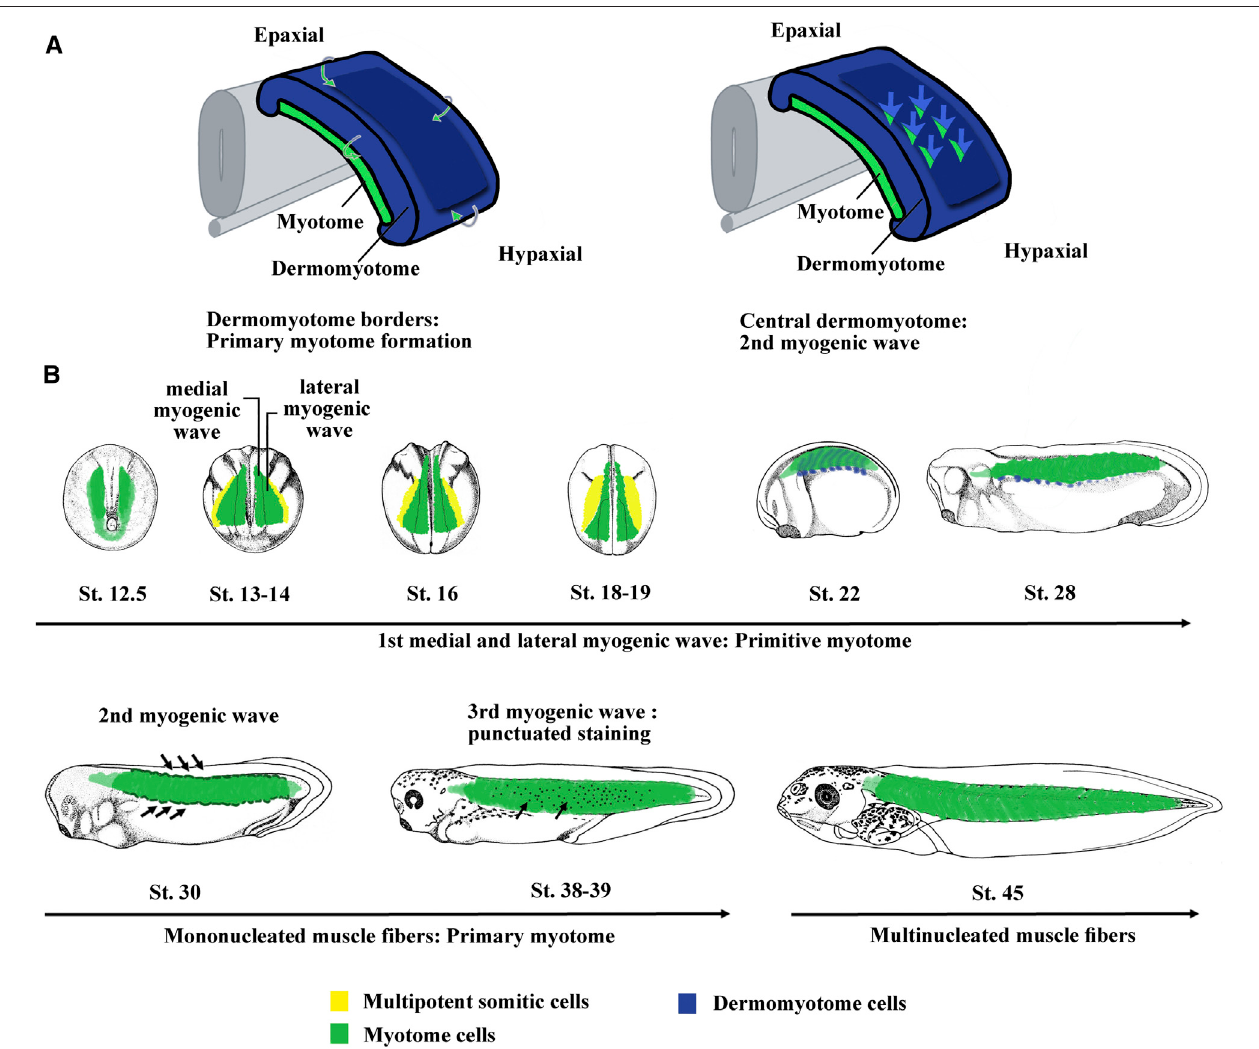
FIGURE 2 | The myogenic waves and the myotome formation in amniotes and Xenopus . (A) The myotome is essentially derived from the dermomyotome in amniotes.Theprimarymyotomeismadeofmononucleatedcellsarisingfromthefourbordersofthedermomyotome.Nextcellscomingfromthecentraldermomyotome invade the primary myotome and contribute to the myotome growth. Hence, two myogenic waves are at the origin of myotome formation. Modi fi ed from Lagha et al. (2008a). (B) Myotome is the main somite compartment in Xenopus and is formed by at least three myogenic waves. The fi rst myogenic wave is made up of two subpopulations, a medial and a lateral one, constitutes the primitive myotome and arises directly from paraxial mesoderm. The second myogenic wave arises from epaxialandhypaxialborderofthedermomyotomeatstage28 – 30.Thethirdmyogenicwavehasbeenvisualizedbymyf5mRNAstainingthatmarkedisolatedroundcells inside the myotome at stage 37 – 38. The myotomeis initially made up of mononucleated fi bers until stage 45 when the fi rst multinucleated muscle fi bers were observed. Hence, it can be considered that both the fi rst wave of primitive myotome and the second wave of hypaxial and epaxial dermomyotome contribute to the formation of primary myotome. The third could participate to plurinucleated fi bers formation and myotome growth. St., stage.